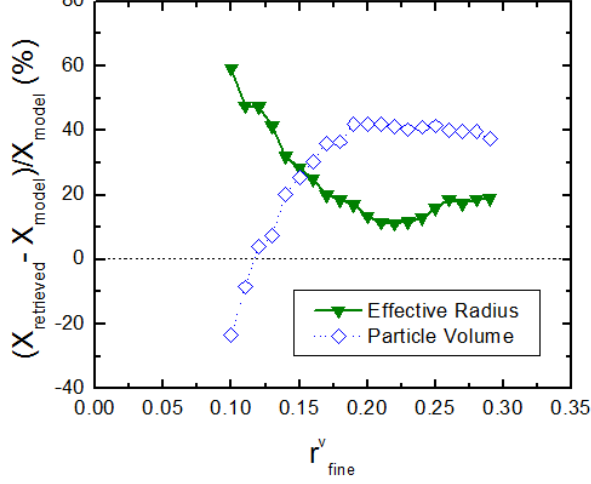
Figure 3. Relative differences of effective radius and columnar vol- ume aerosol content vs. the fine mode effective radius of the input model size distribution. Data correspond to Scenario